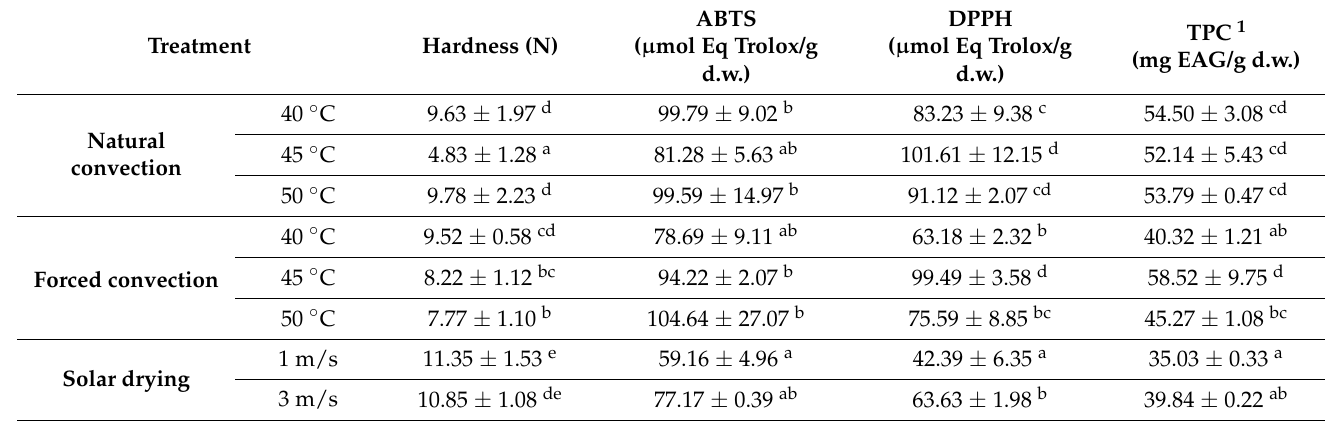
Table 3. Hardness, total phenolic content, ABTS, and DPPH antioxidant activity of extracts obtained from dried peach slices by natural and forced convection at different